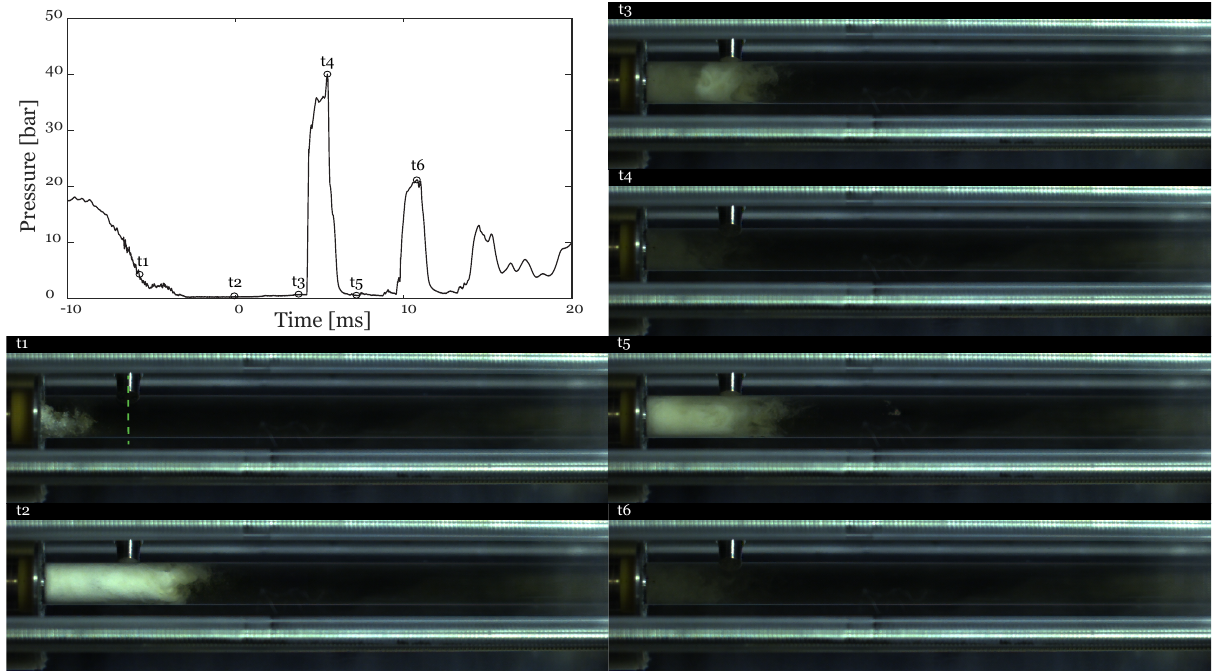
Figure 5. High-speed camera images of the vapor cavities after valve closing for Re = 2239 at different snapshots (t1 to t6). The graph inset shows the corresponding pressure response at P1 (green dashed line in t1). For camera settings, see Table 2 (low).